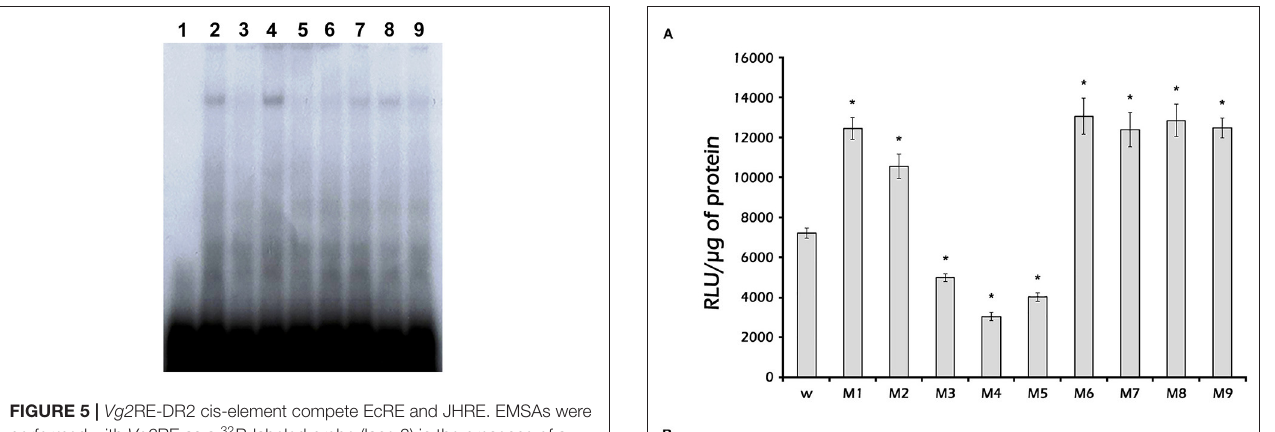
FIGURE 5 | Vg2 RE-DR2 cis-element compete EcRE and JHRE. EMSAs were performed with Vg2 RE as a 32 P-labeled probe (lane 2) in the presence of a 20-fold excess of unlabeled self-competitor (lane 3), EcREs of hsp DR4, and hsp IR (lanes 5 and 6, respectively) or JHREs of jhbp21 , JHE, and CF1/USP (lanes 7, 8, and 9, respectively). The negative and positive controls were the probe alone without or with nuclear protein (lanes 1 and 4, respectively).